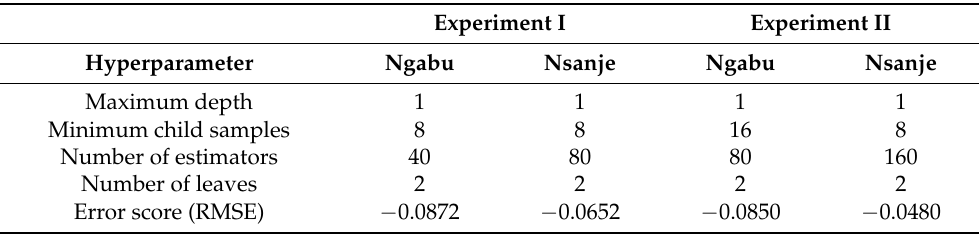
Figure 7. Pearson ’ s product – moment cross-correlation plots for each of the input features and the target feature. The correlation coefficients are displayed on the plot. Please refer to Table 2 for a description of the labels. Table 6. Optimal hyperparameter settings determined through the gridsearch 10-fold